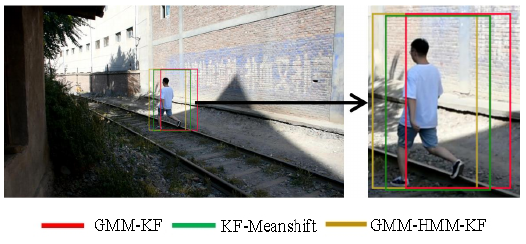
Fig. 12. The original image of the 285 th frame of video 3